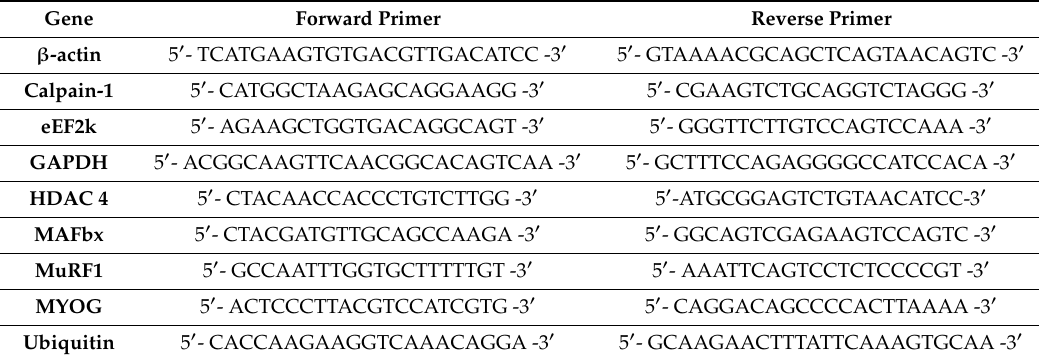
Table 1. Primers used for QRT-PCR